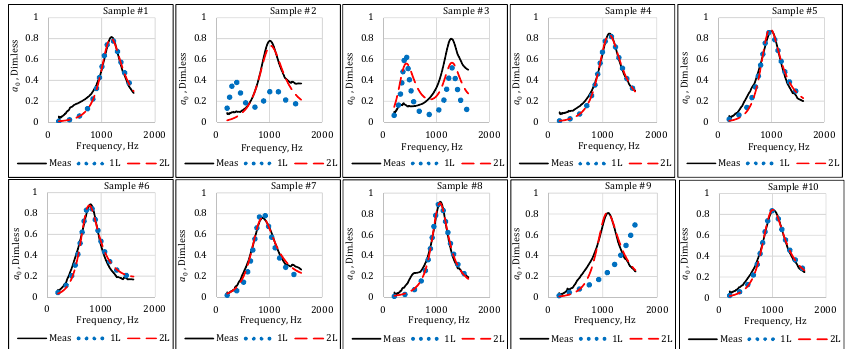
Figure 4. a 0 plots (optimization in 200–1600 Hz, measured resistivity)